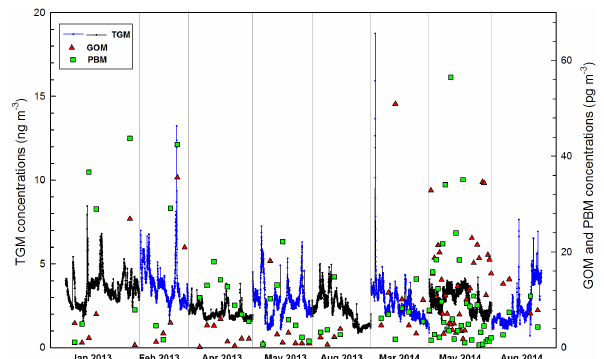
Figure 2. TGM, GOM, and PBM concentrations measured during the eight sampling periods. TGM was measured every 5min while GOM and PBM were measured during 12h except for the 2h mea- surements during May